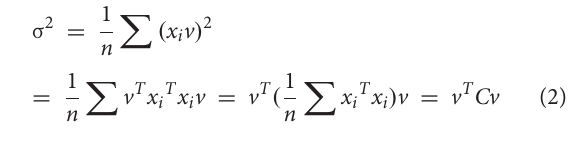
combined to control laser energy and a plano-convex lens ( f = 100 mm) was fixed to focus the laser beam 2 mm below the surface of the sample. To avoid repeat ablations, an X-Y- Z motorized stage was applied to move the sample every ten accumulation shots. The LIBS spectra were separated by the high- resolution Echelle spectrometer (ME5000, Andor Information Technology Ltd., Belfast, United Kingdom) in the range of 230–904 nm with 0.01 nm resolution and then collected by Andor Information Technology Ltd., Belfast, United